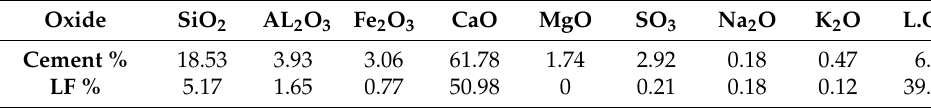
Figure 1. Particle size distribution of the LF and cement. Table 1. Chemical composition of cement and LF.